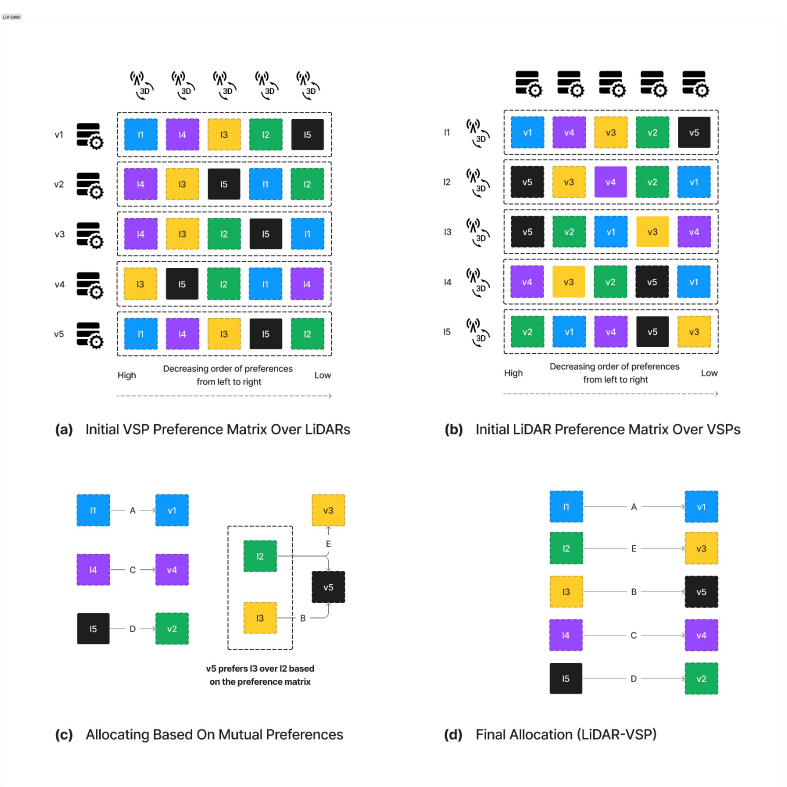
Figure 4. The detailed functioning of the LiV-DAM algorithm (Algorithm 1) where the number of LiDAR sensors is equal to the number of VSPs ( n =